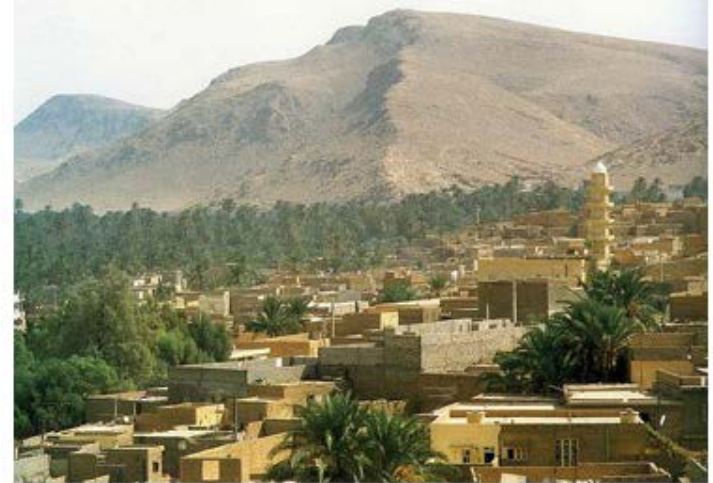
Figure 10. The historic quarter of Boussaada (Algeria)